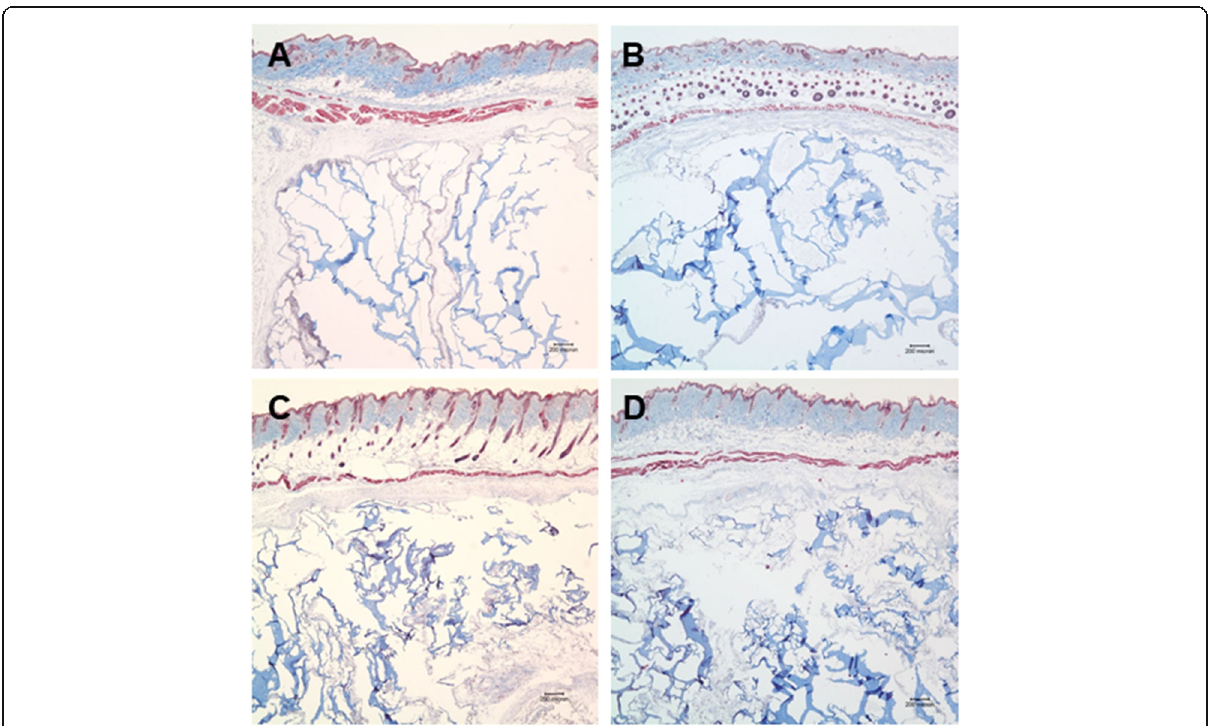
Fig. 3 Microscopic view of the hydrogel groups stained with Masson ’ s trichrome stain. All soft tissues inside the hydrogel were stained blue (Masson ’ s trichrome; original magnification, × 40). a Hydrogel alone, b hydrogel combined with bFGF, c hydrogel combined with fibroblasts, and d hydrogel mixed with bFGF and